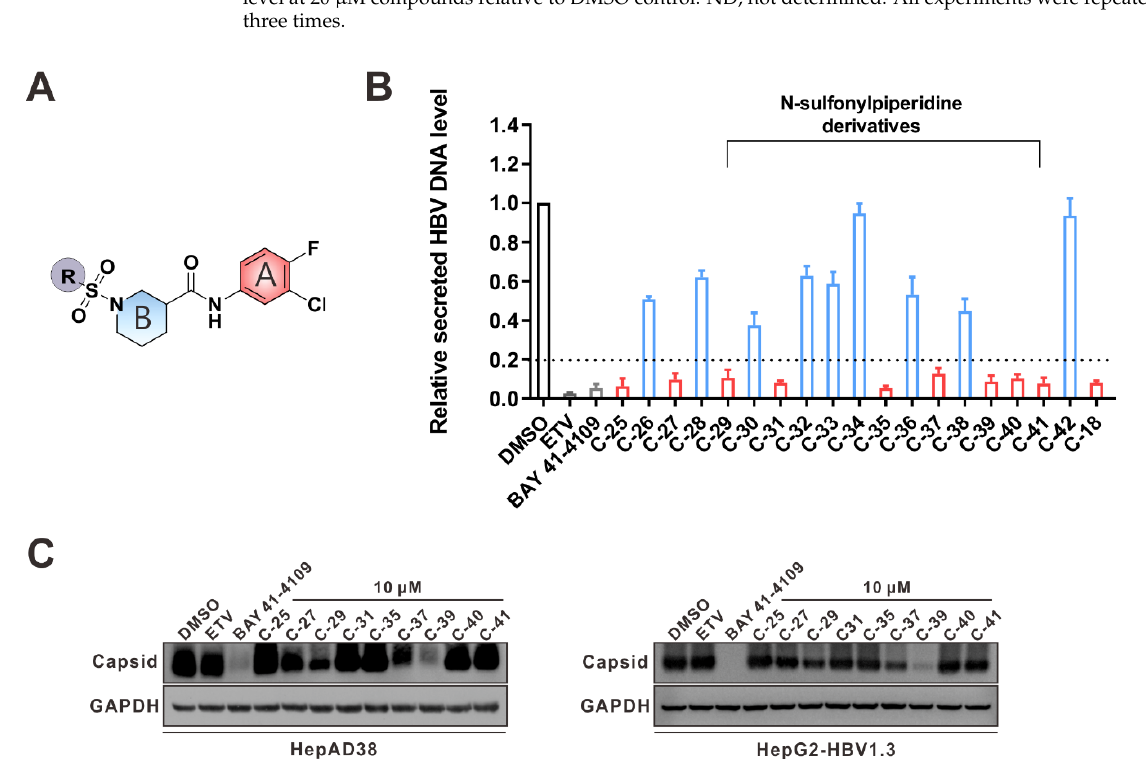
Figure 5. Effects of the rescreened compounds on HBV replication and capsid formation. ( A ) The scaffold of C-18. The substituent on the SPC scaffold was represented as an R group. Ring A and ring B are highlighted. ( B ) Effects of the 18 compounds (C-25–C-42) and C-18 on secreted HBV DNA in HepAD38 cells. The threshold for hit selection was set stringently to a 20% residual level relative to the control (DMSO). Data are representative of three independent experiments and are expressed as the mean ± SD. ( C ) Effects of nine selected compounds on intracellular HBV capsid formation. HepAD38 and HepG2-HBV1.3 were incubated with nine selected compounds (10 μM), ETV (25 nM), and BAY 41-4109 (2 μM) for 6 days. Table 2. The anti-HBV activity of C-25–C-42 in HepAD38 or HepG2-HBV1.3 cells.